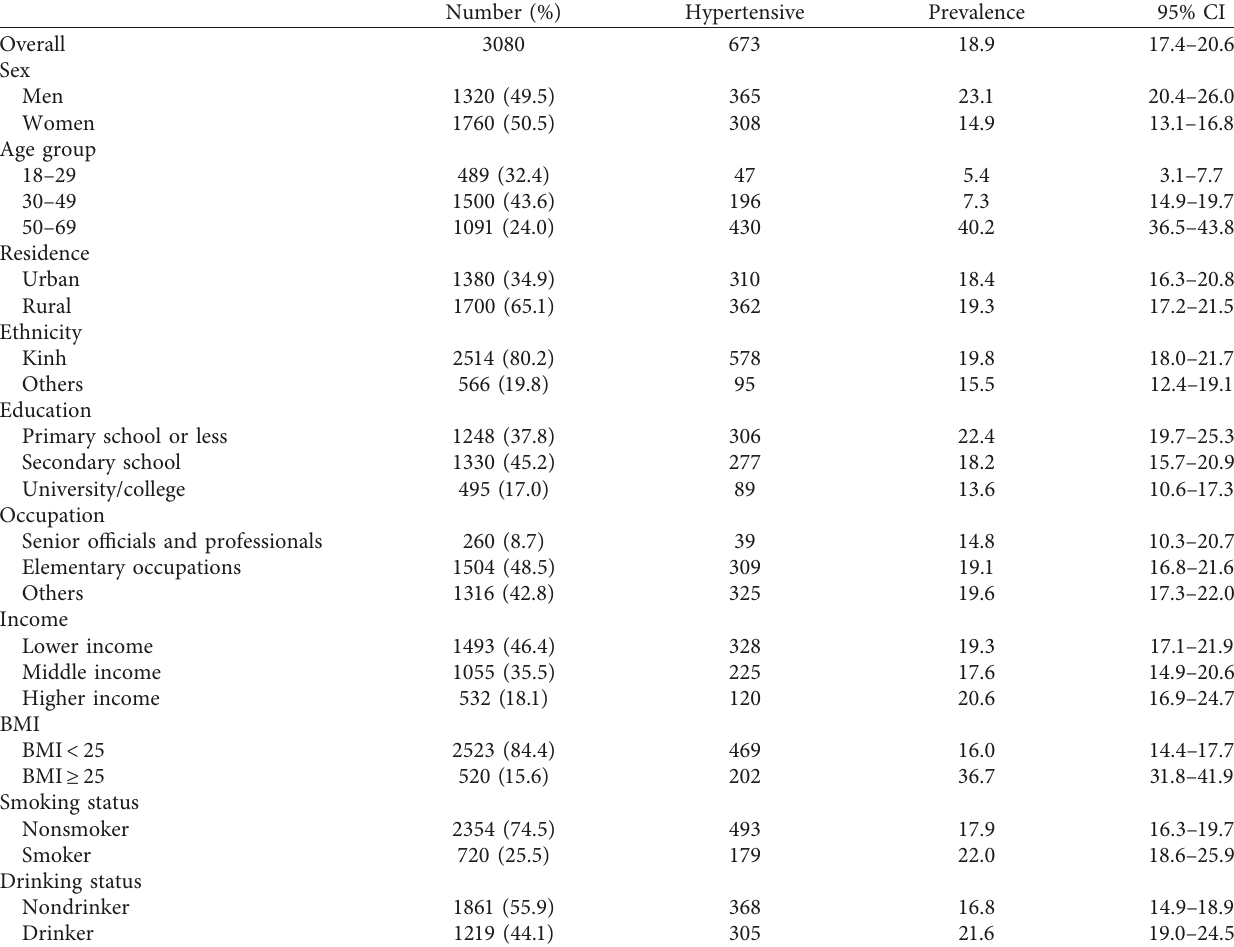
Table 1: Prevalence of hypertension by sociodemographic factors and NCD risk factors, Vietnam